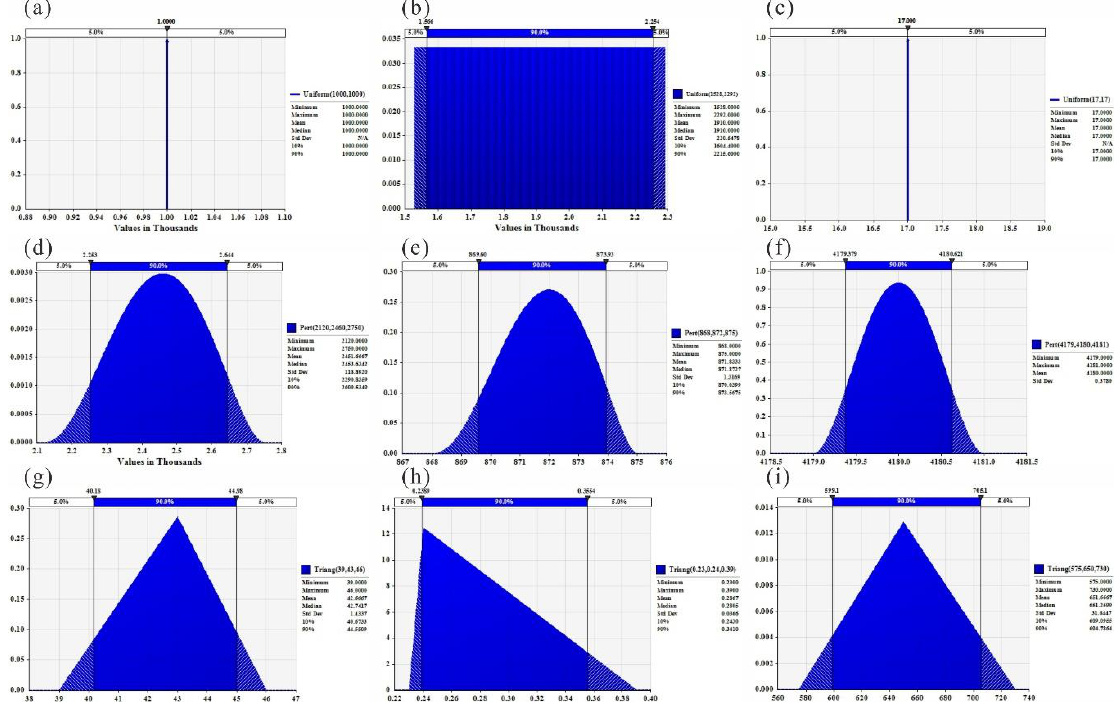
Figure 4. Distribution models of input parameters in the Jinhu sag (( a ) water density; ( b ) the geothermal reservoir area; ( c ) the annual average temperature; ( d ) the geothermal reservoir rock density; ( e ) the specific heat of rocks; ( f ) the specific heat of water; ( g ) geothermal reservoir temperature; ( h ) the geothermal reservoir rock porosity; ( i ) the thickness of the geothermal